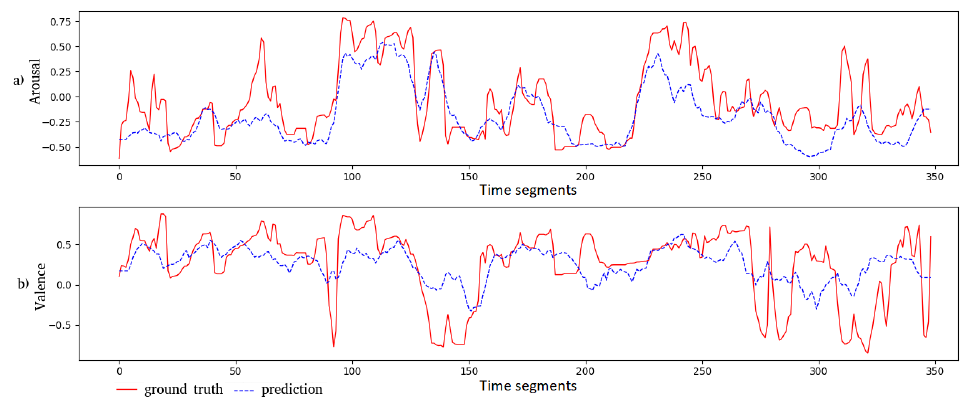
Figure 6. Both the ground truth and the predicted outputs of the Feature AAN model for the “Ratatouille” movie clip are visualized: ( a ) for arousal and ( b ) for valence. Each time segment in the graphs corresponds to 5 s, which is also the duration of each movie